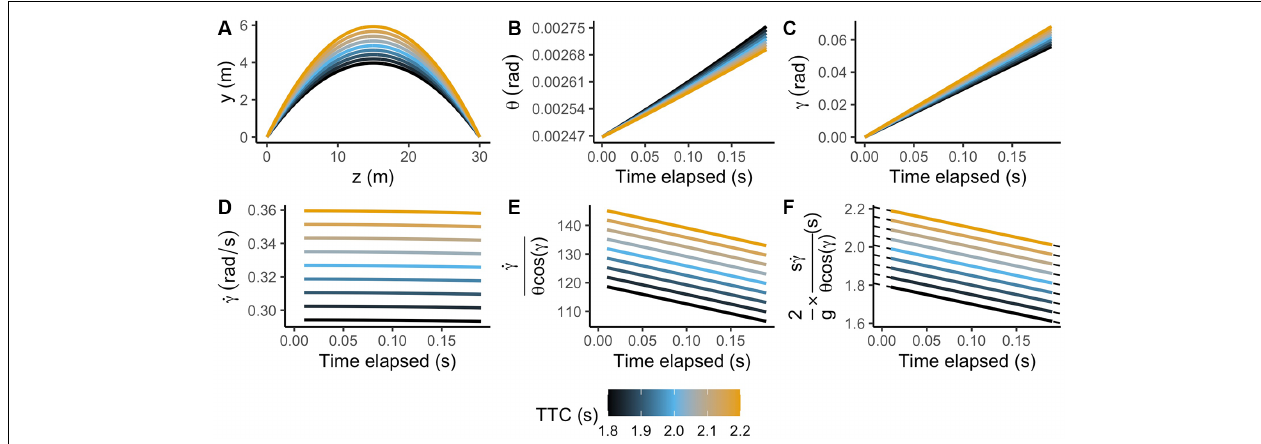
FIGURE 4 | Test parabolas used in the simulation. (A) Ball’s vertical vs. depth position. Panels (B–D) indicate retinal size ( θ ), elevation angle ( γ ) and rate of change of the elevation angle ( ˙ γ ) as a function of time for the first 200 ms of the trajectory. Panels (E,F) depict the output of the GS model using visual information only and combined with prior information, respectively.